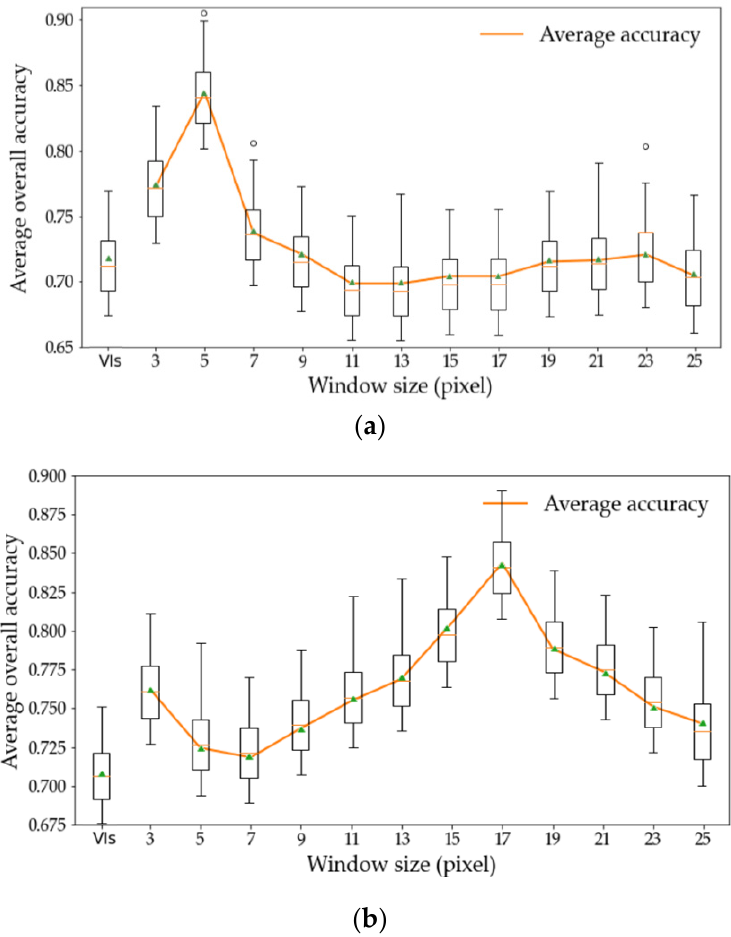
Figure 6. The average values and a box map of the model accuracies. Obtained utilizing only spectral features (the leftmost) and combined spectral features and texture features in windows of different sizes (right), on May 3 ( a ) and May 8 ( b ).